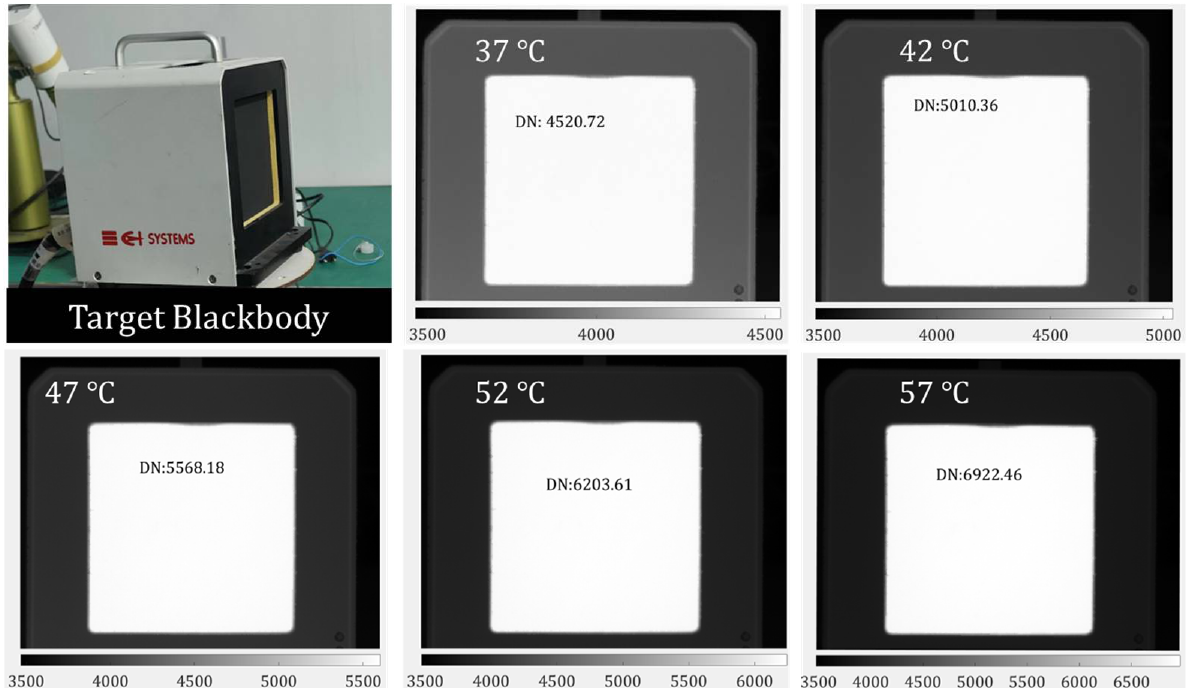
Figure 9. Target blackbody and its imaging at different temperatures. Table 4. The inversion data of two calibration methods, and the error between them.